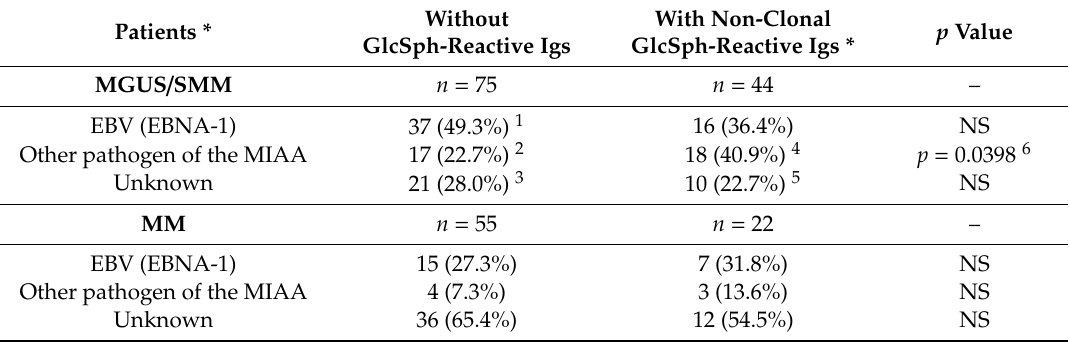
Table 2. Infectious pathogen-specificity of monoclonal Igs in MGUS / SMM and MM according to the presence or absence of non-clonal GlcSph-reactive Igs.